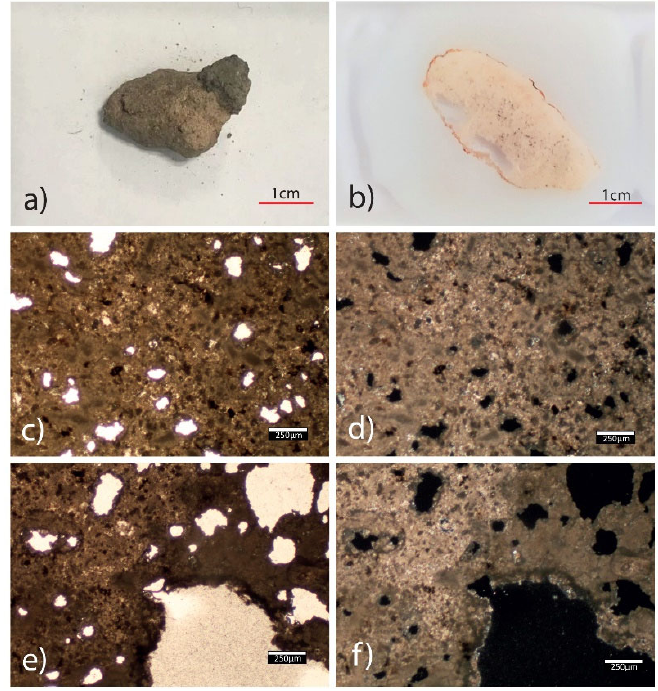
Figure 10. Sample MIN9 (Group P4b) microphotographs under polarised light microscopy (PL-OM). Limestone samples with lime plaster thin layer. ( a ) analysed fragment; ( b ) homogeneous thin section with a thin layer around the fragment with different composition; ( c ) parallel polars and ( d ) crossed polars: microcrystalline calcitic matrix; ( e ) parallel polars and ( f ) crossed polars: variable porosity on lime plaster matrix with size frequently from 70 up to 1200 µ